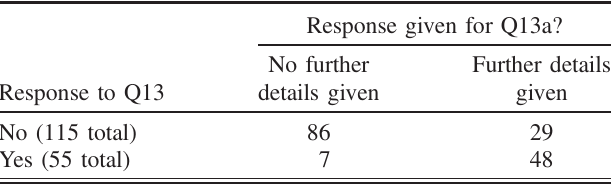
TABLE I. Response counts for questions 13 and